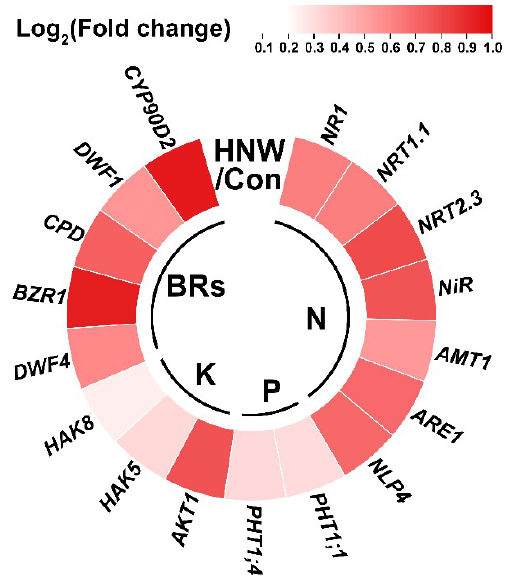
Figure 3. Molecular evidence showing that the results of rice seed size might be causally related to absorption of N, P, and K, as well as BRs signaling. Transcripts of genes related to absorption of N, P, and K in root tissues, and BRs signaling in young panicles were analyzed by qPCR. The samples were obtained on 5 September 2020. The different color means different log 2 (fold change) of HNW contrast Con.